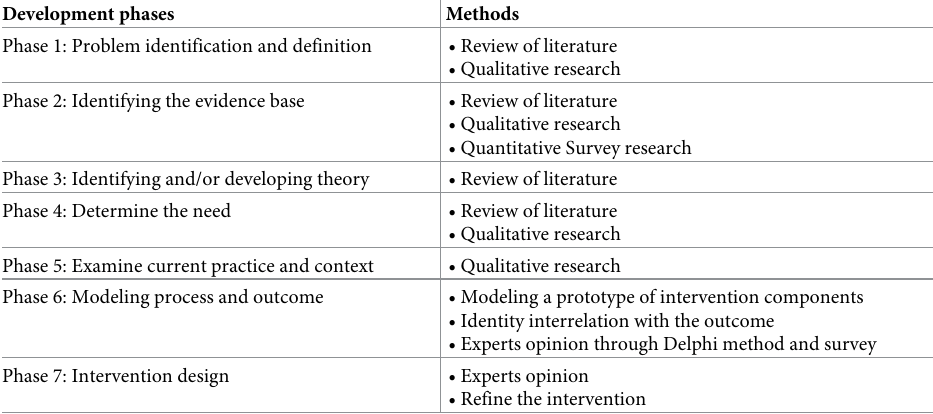
Table 1. Mobile-assisted medication adherence support intervention development process using an adapted development phase of MRC framework and the associated